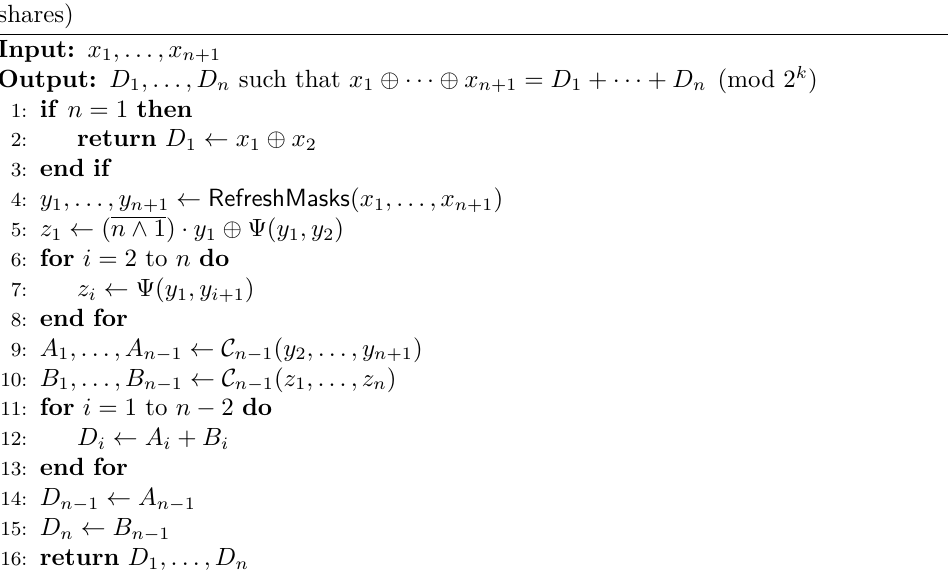
Algorithm 2 C n : Recursive high-order Boolean to Arithmetic Conversion ( n + 1 → n